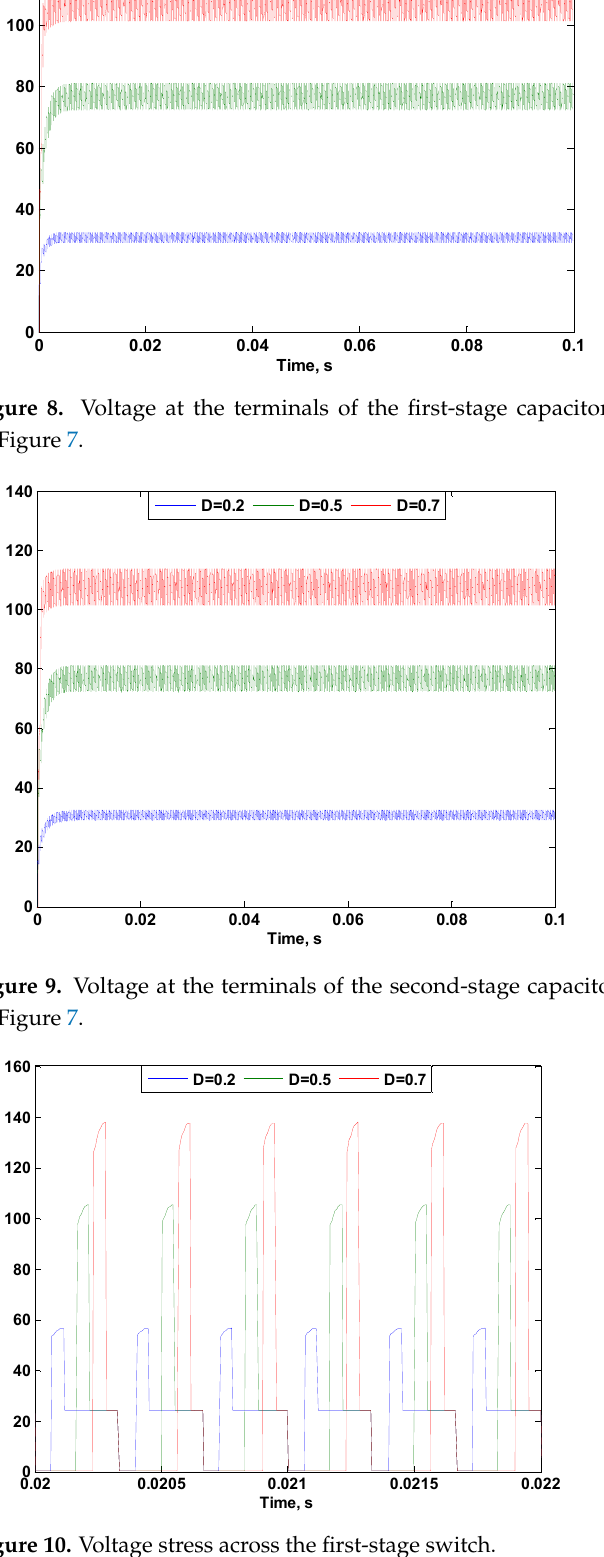
Figure 11. Voltage stress across the second-stage switch. 4.2. Performance of the Suggested Converter When Excited from Three DC Sources during the Excitation of a Resistive–Inductive Load